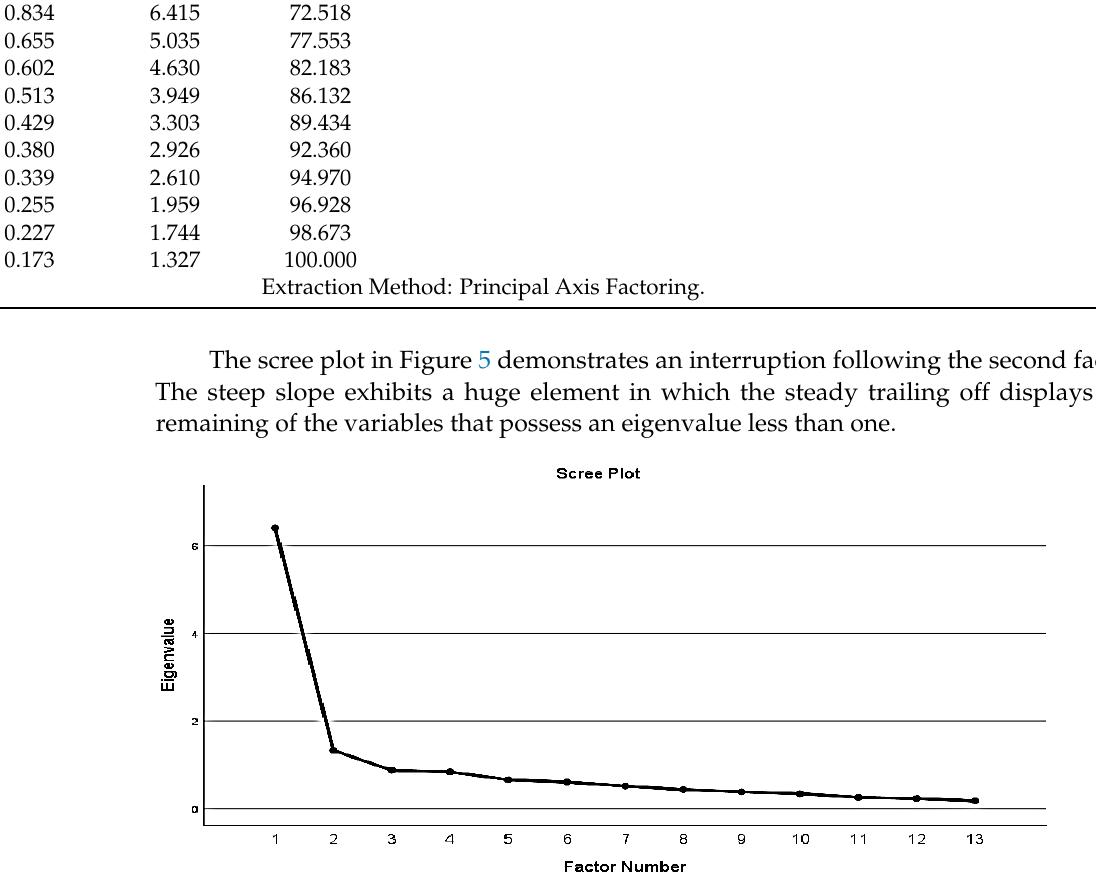
Figure 5. Respondents’ professions.